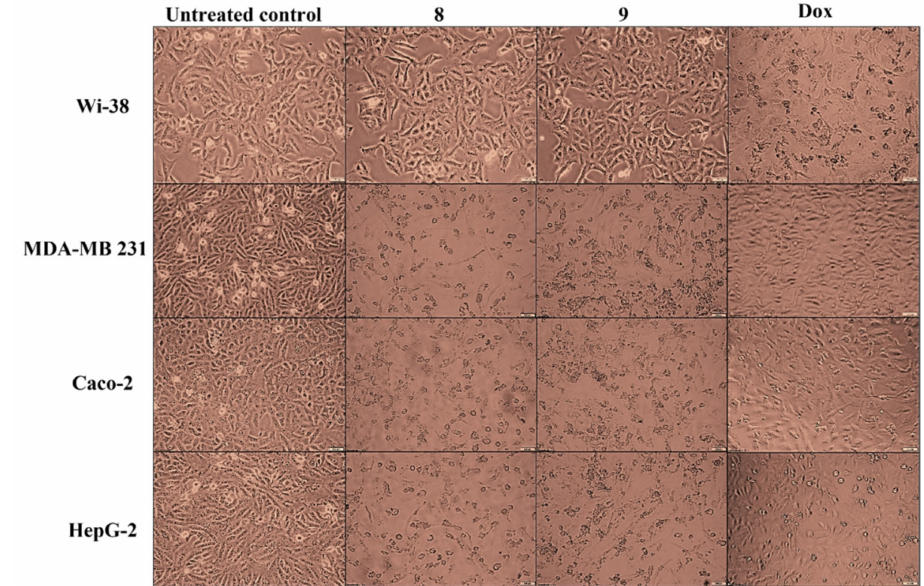
Figure 3. Morphological alteration of 8- and 9 -treated Wi-38 cells (at 30 nM), MDA-MB231 , Caco-2 , and HepG-2 (at 1 nM) compared to Dox- treated and control